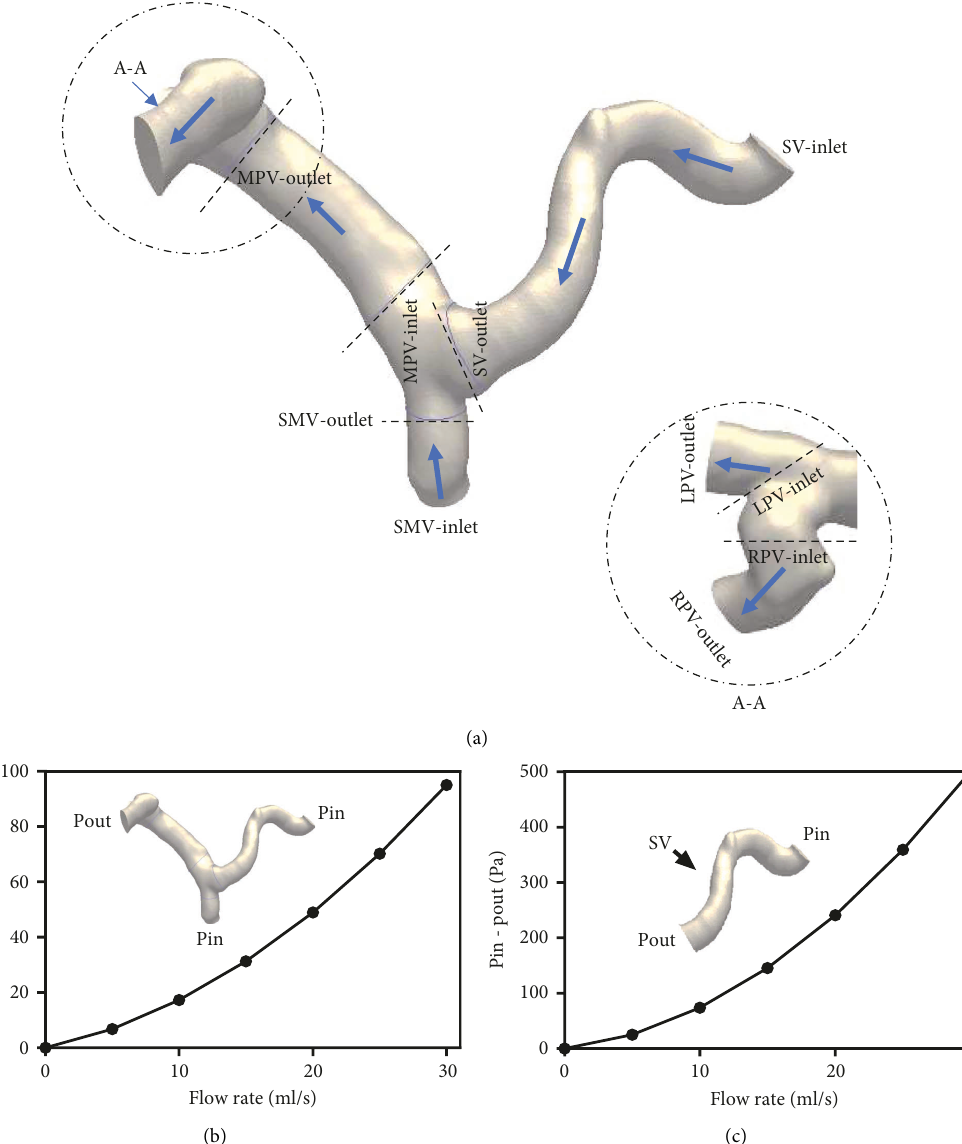
Figure 2: Example of portal vein segmentation and flow resistance calculation. (a) PV segmentations. (b) Overall flow resistance of PV ( A � 0.072Pa/(mL/s)2; B � 1Pa/(mL/s)). (c) Flow resistance of SV ( A � 0.745Pa/(mL/s) 2 ; B �